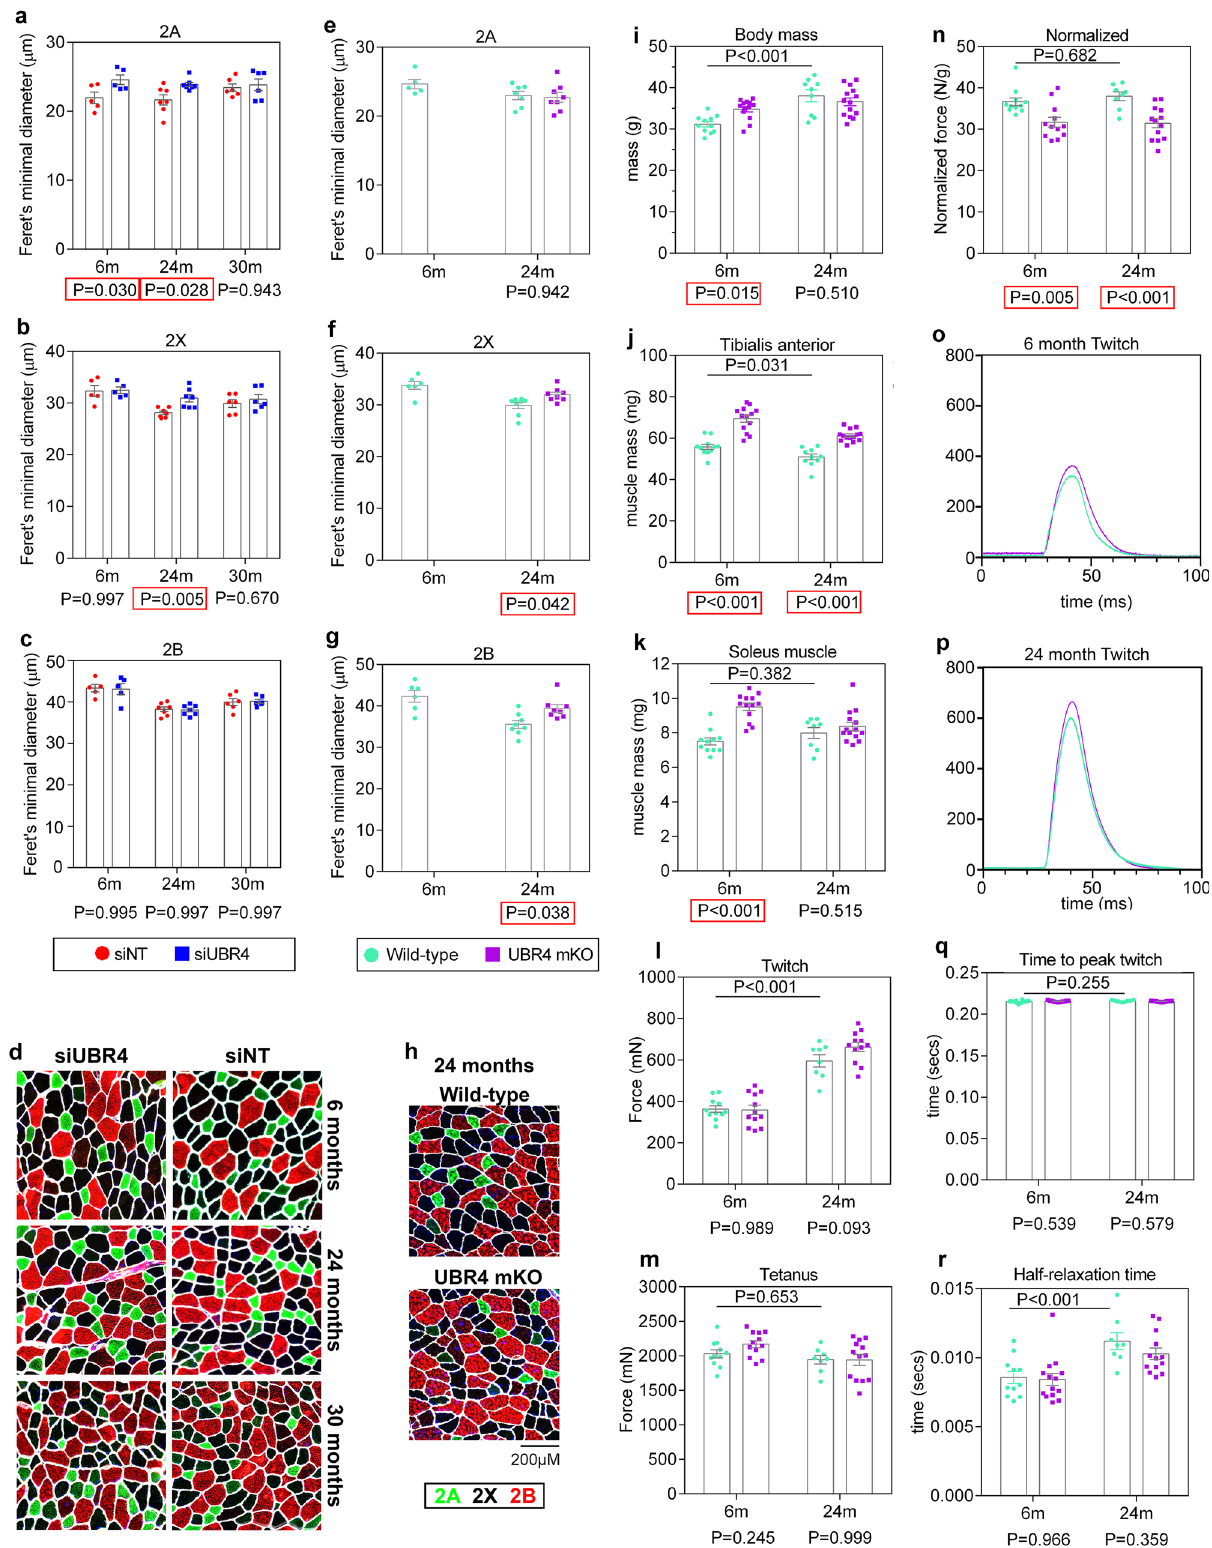
6-month-old UBR4 mKO mice but such hypertrophy was missing in 24-month-old UBR4 mKO mice (Fig. 1k). Although body mass was not signi fi cantly different between genotypes at 24 months of age (Fig. 1i), the mass of tibialis anterior and soleus muscles normalized to total body mass indicated a dramatic drop in the